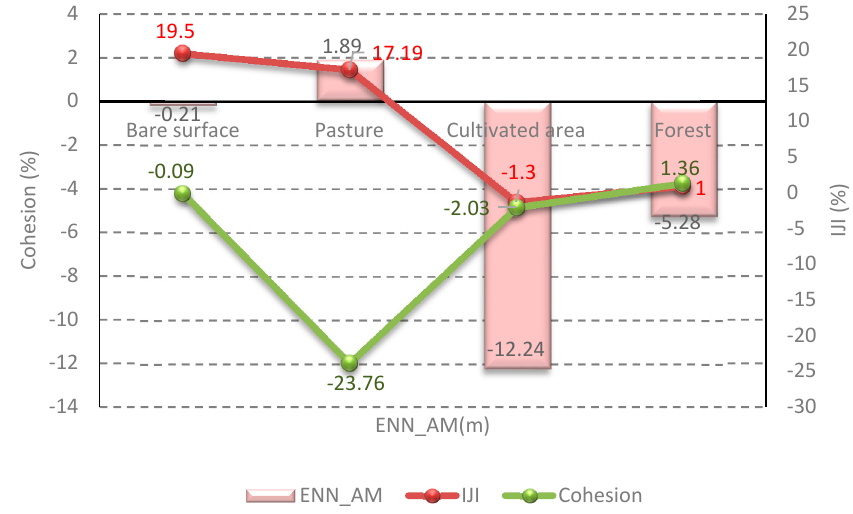
Figure 7. Gains and losses of ENN_AM, IJI and Cohesion of LULC by category in different time periods (199–2015) in the lower part of the HSCZ.